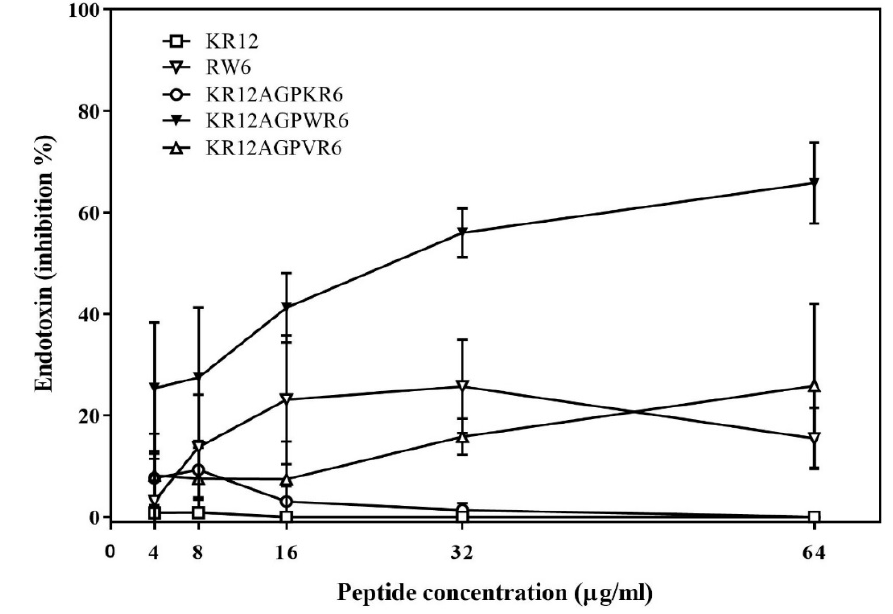
Figure 3. Lipopolysaccharide (LPS) -neutralizing activities determined by limulus amebocyte lysate (LAL) assay. The experiments were performed in triplicate. Results are presented as means ± standard deviations (SD).